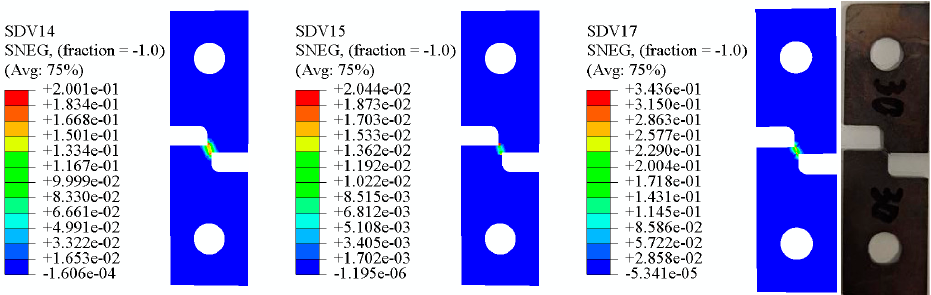
Figure 13. Equivalent plastic strain, VVF, shear damage at the beginning of microcrack in 15° specimen, and the result diagram of the specimen.